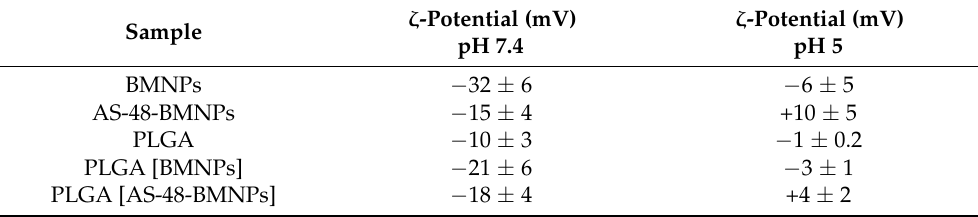
Table 3. ζ -Potential (mV) values at physiological and acidic conditions, pH 7.4 and pH 5, respec- tively. The data correspond to the average of three independent experiments for which the standard deviation has been